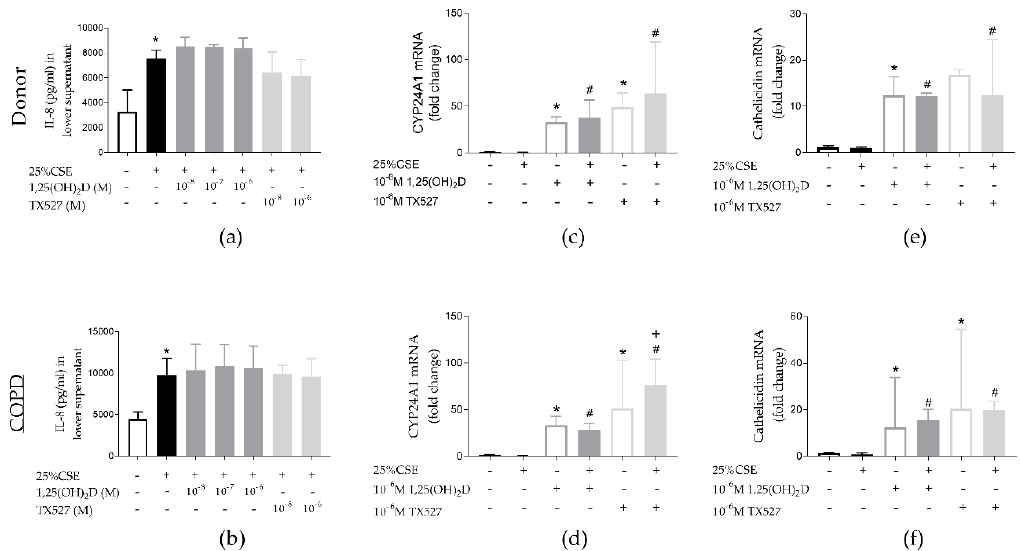
Figure 6 . Effect of CSE and vitD exposure on primary bronchial epithelial cells (PBEC) of unused Figure 6. E ff ect of CSE and vitD exposure on primary bronchial epithelial cells (PBEC) of